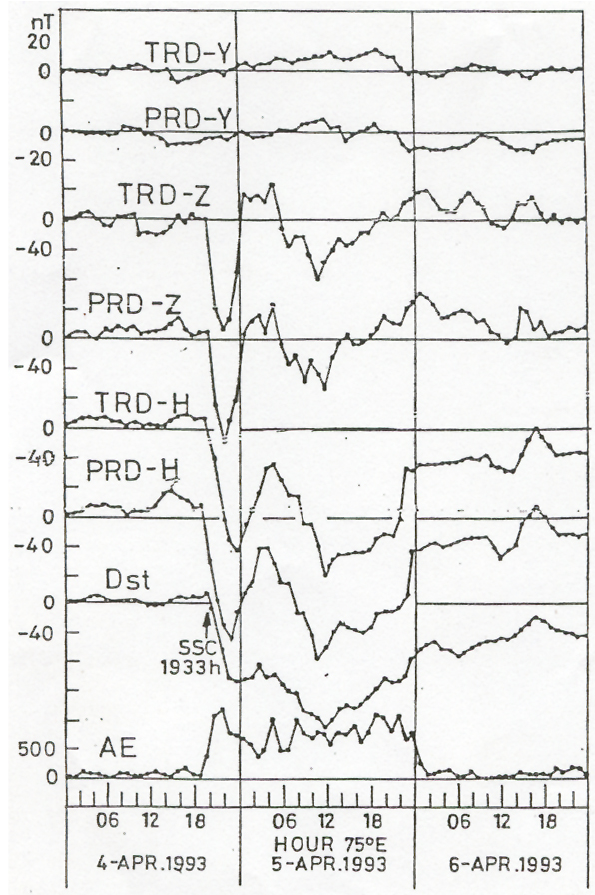
Fig. 10. Storm time variations of H , Y and Z fields at PRD and TRD during the magnetic storms starting at 19:33 LT on 5 April